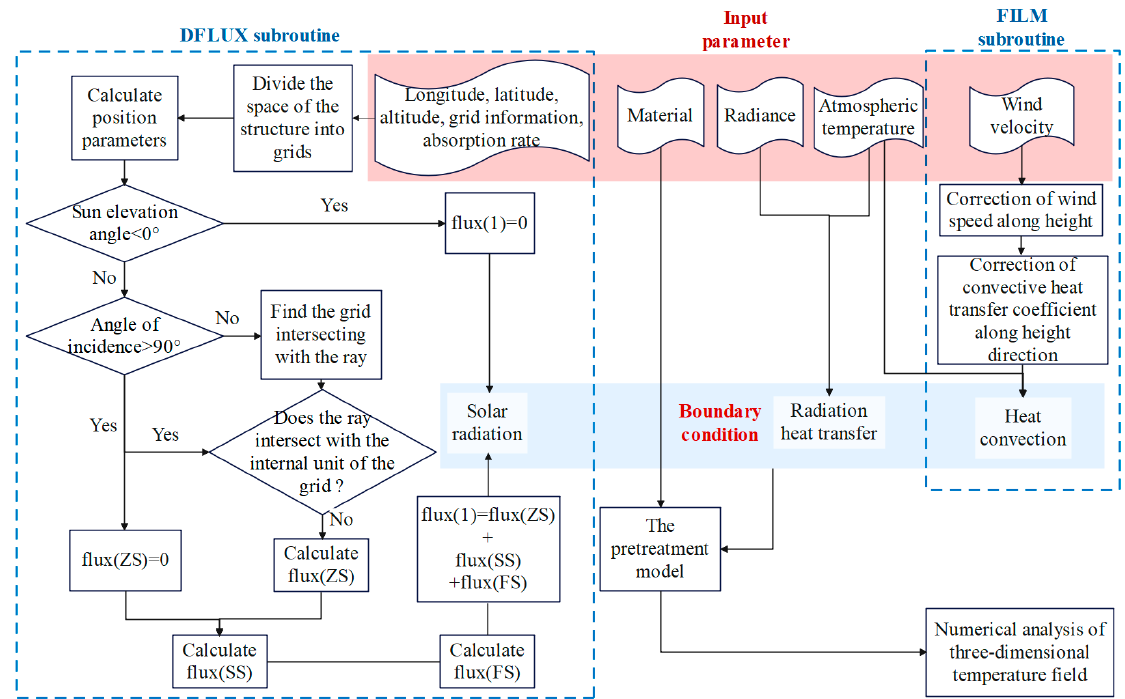
Figure 4. Flow chart of numerical simulation of 3D temperature field caused by solar radiation.